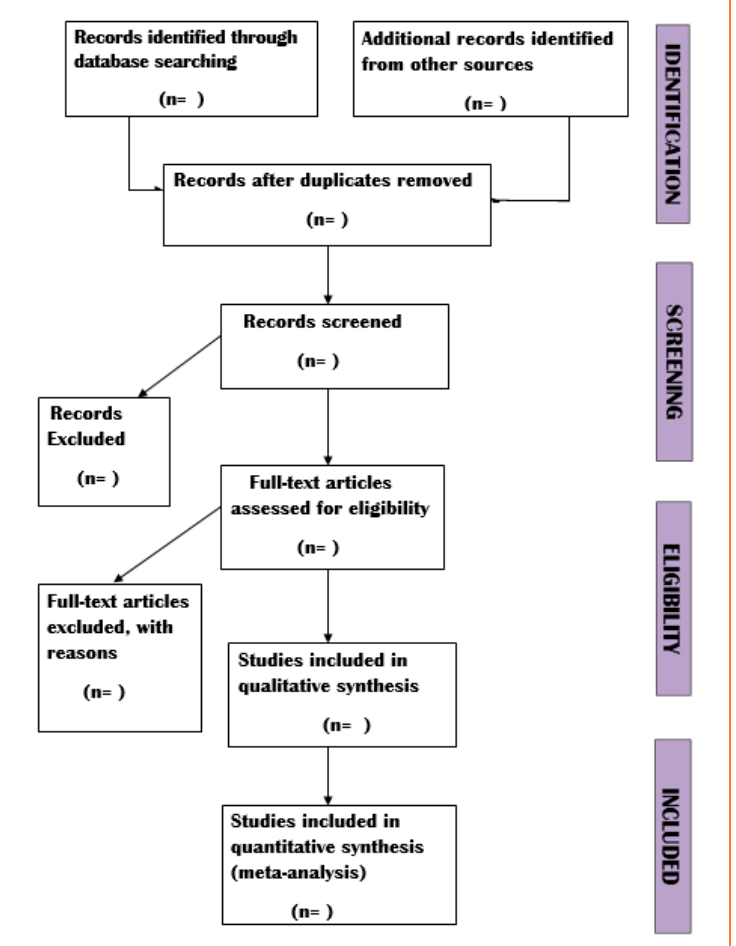
Figure 1. Flow chart: its role has garnered massive attention from researchers who are trying to identify their roles in CC. One of the major tasks carried out by scientists is to identify how well miRNAs regulate chemoresistance in CC. Through this study, we are trying to correlate all the data and increase the understanding of the function of miRNAs in CC.